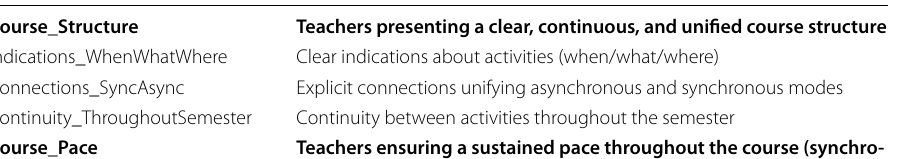
Table 3 Meta-category: course structure and pace